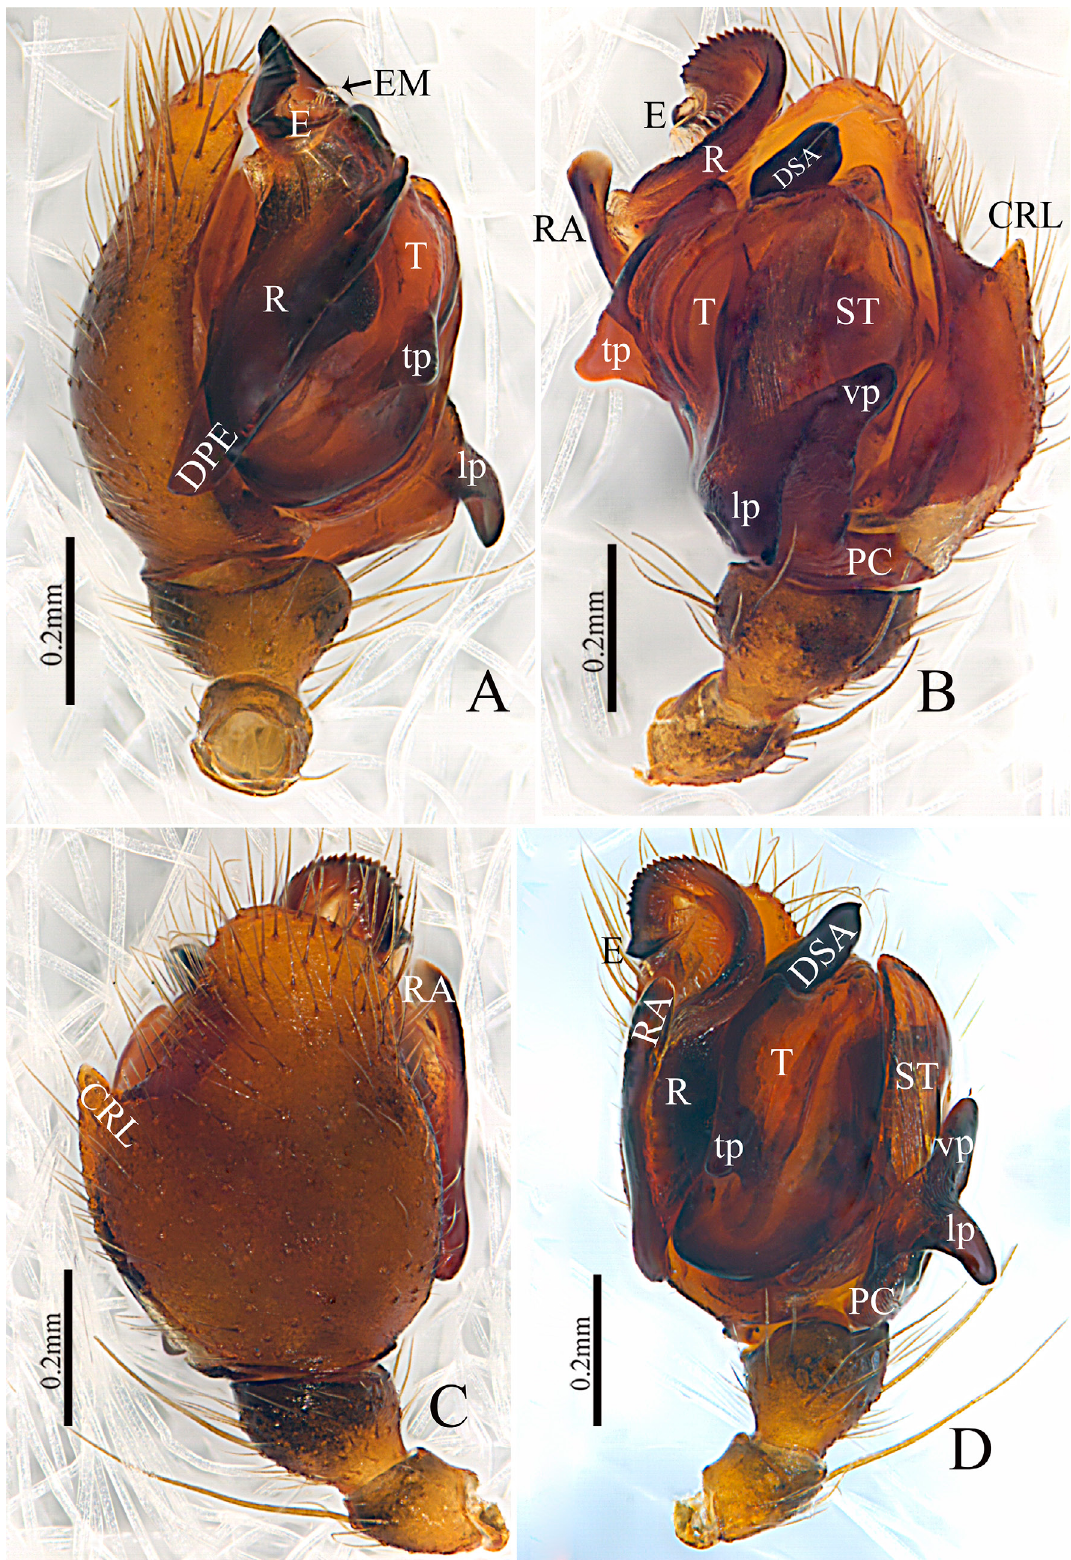
Fig. 24. Acroterius latus gen. et sp. nov., ♂, holotype (HNU-CGY123), palp. A . Prolateral view. B . Retrolateral view. C . Dorsal view. D . Ventral